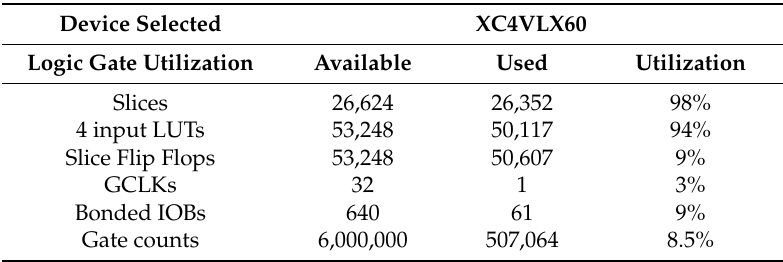
Table 5. Resource requirements of FNFN implementation the backing control of a